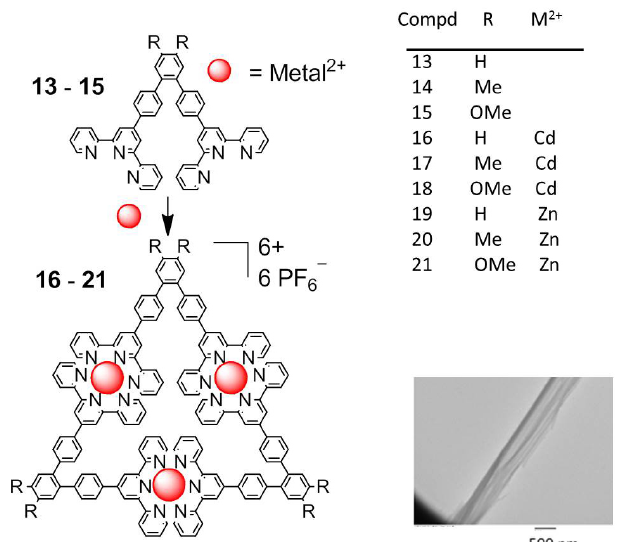
FIGURE 9 – Synthesis of a series of triangular metallocycles and a TEM image of fibers readily formed when the molecular triangles are paired with benzenehexacarboxylate [Schultz, A.; Cao, Y.; Huang, M.; Cheng, S. Z. D.; Li, X.; Moorefield, C. N.; Wesdemiotis, C.; Newkome, G. R. Dalton Trans. , v.41, p.11573- 11575, 2012. – Reproduced by permission of The Royal Society of Chemistry].